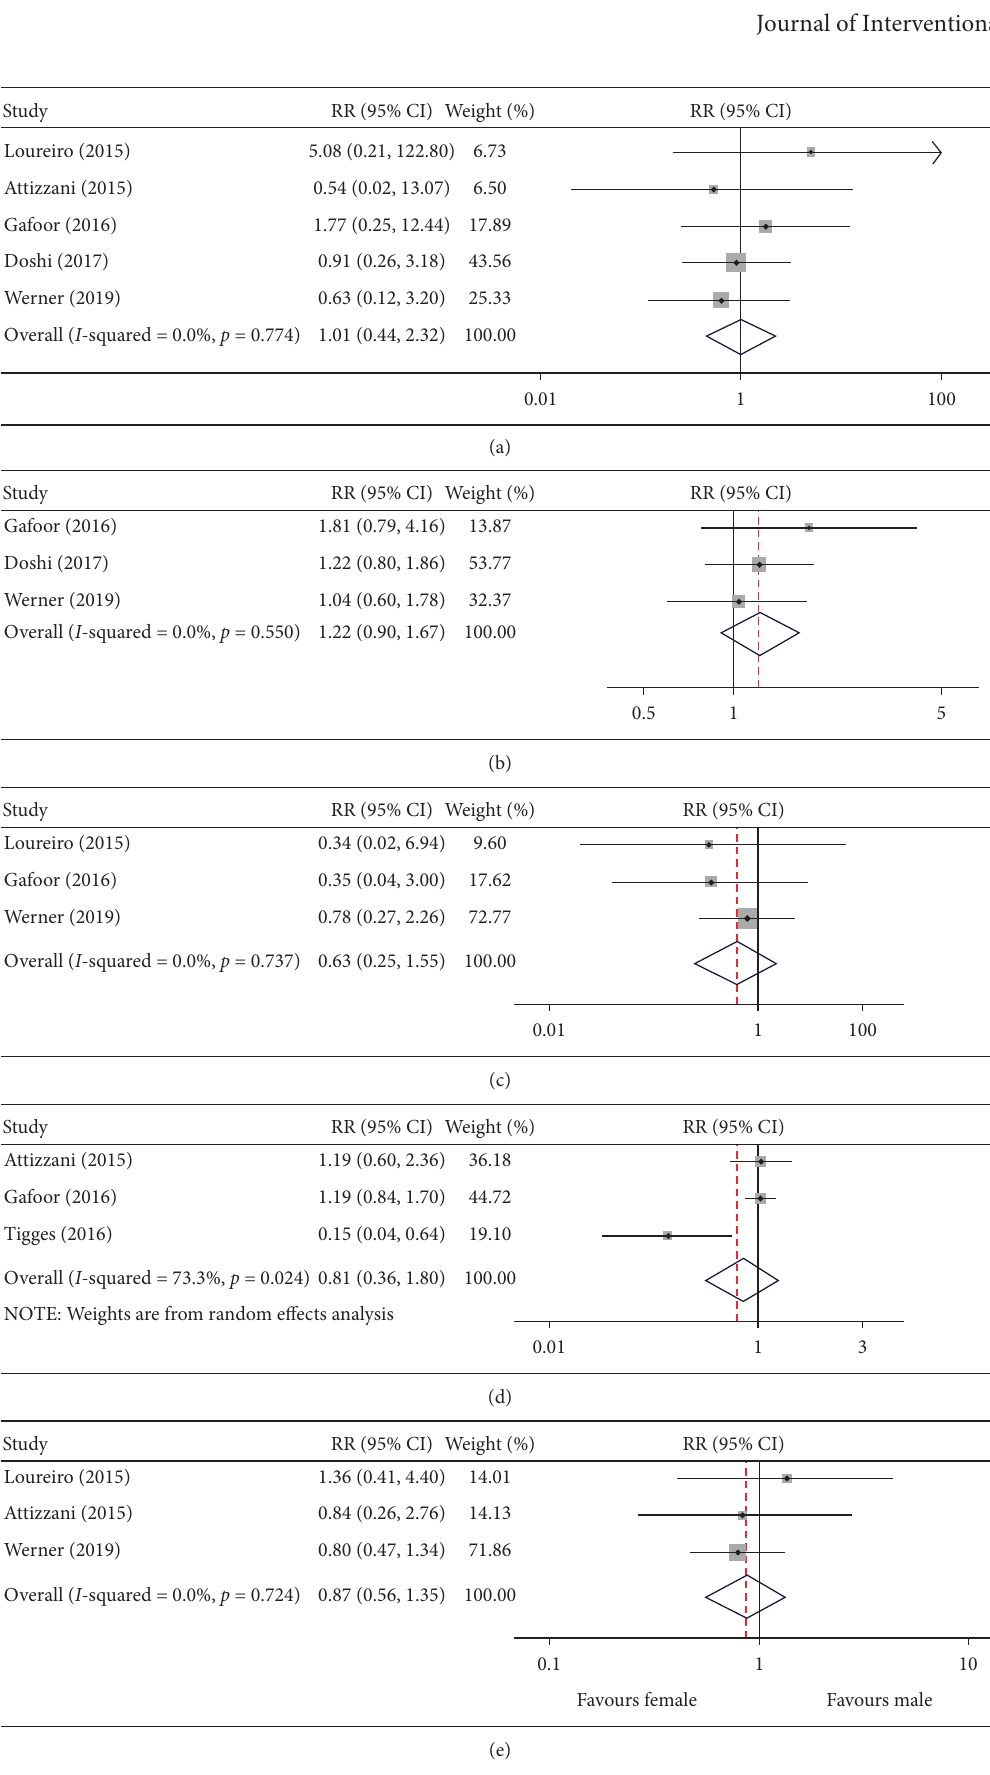
Figure 3: Male versus female. Risk ratio and 95% CI for the pooled endpoints of stroke (a), major bleeding (b), pericardium effusion (c), MR reduction (d), and rehospitalization